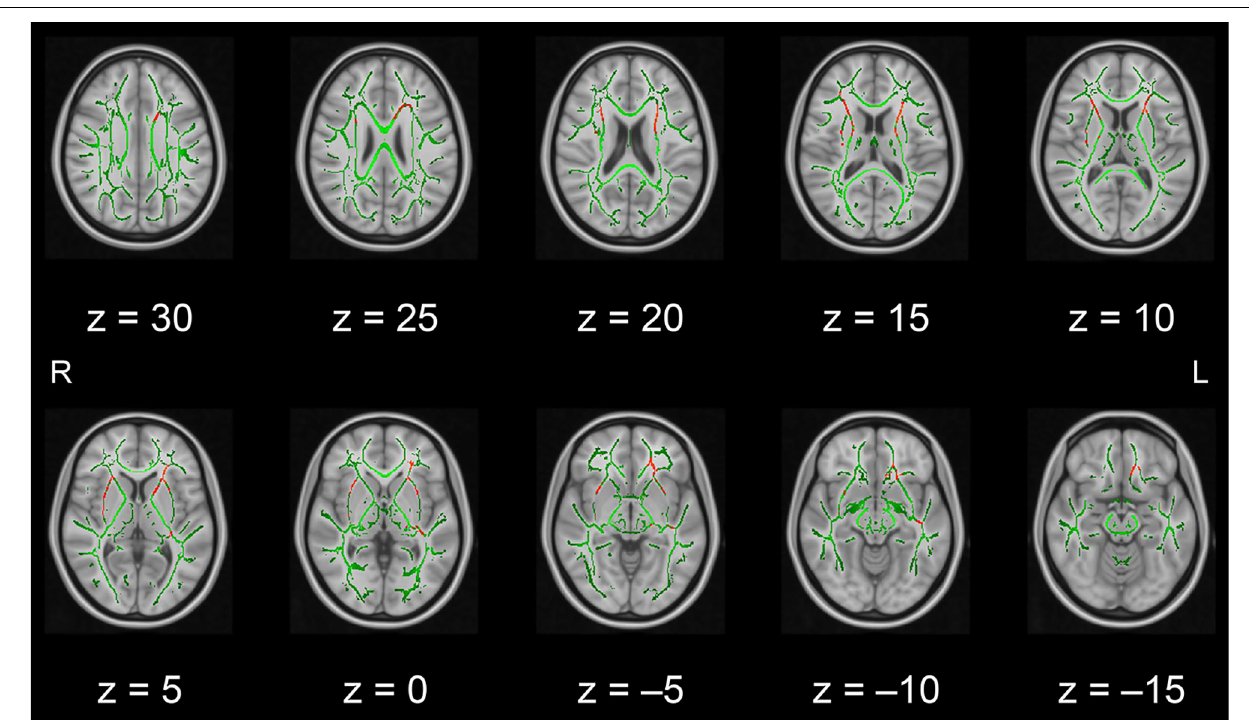
FIGURE 1 | White matter fiber tracts showing significantly higher FA values in the intervention group than in the control group (displayed in red). The results are overlaid on the mean FA skeleton (shown in green) and the standard MNI152 T1 1-mm 3 brain template. The value of z in the horizontal plane represents the MNI z -coordinate. Abbreviation: FA, fractional anisotropy; L, left; MNI, Montreal Neurological Institute; R,